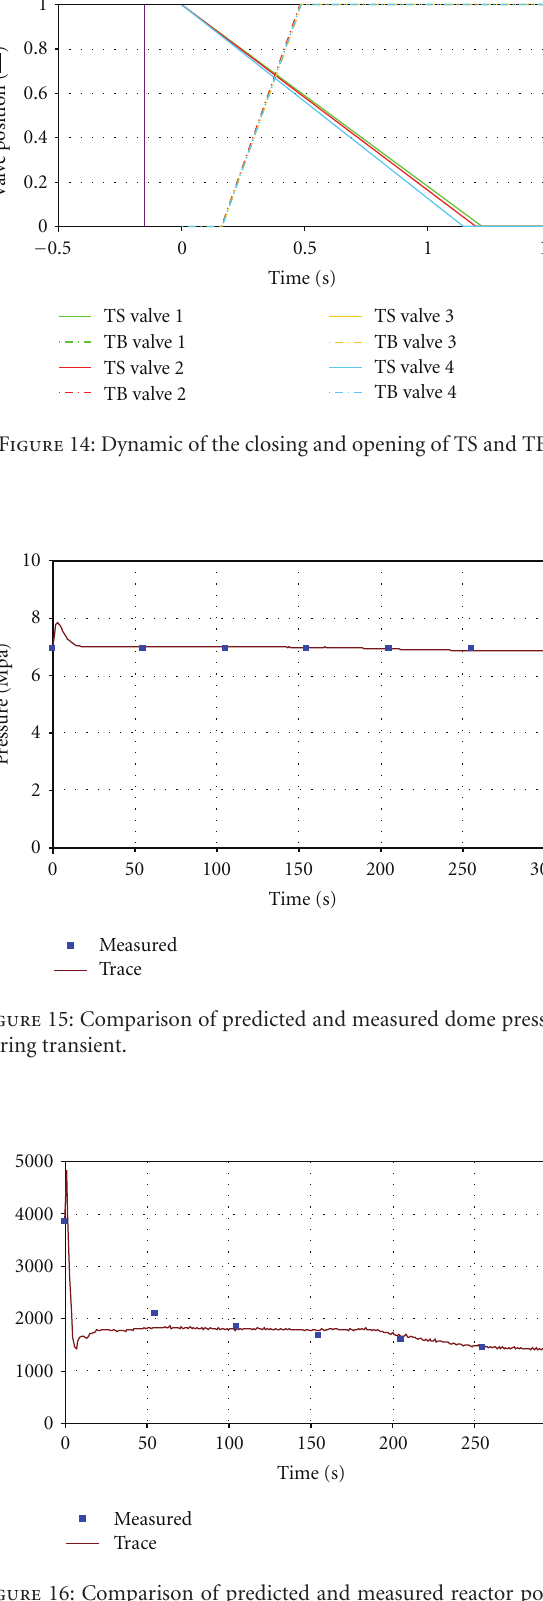
Figure 16: Comparison of predicted and measured reactor power during